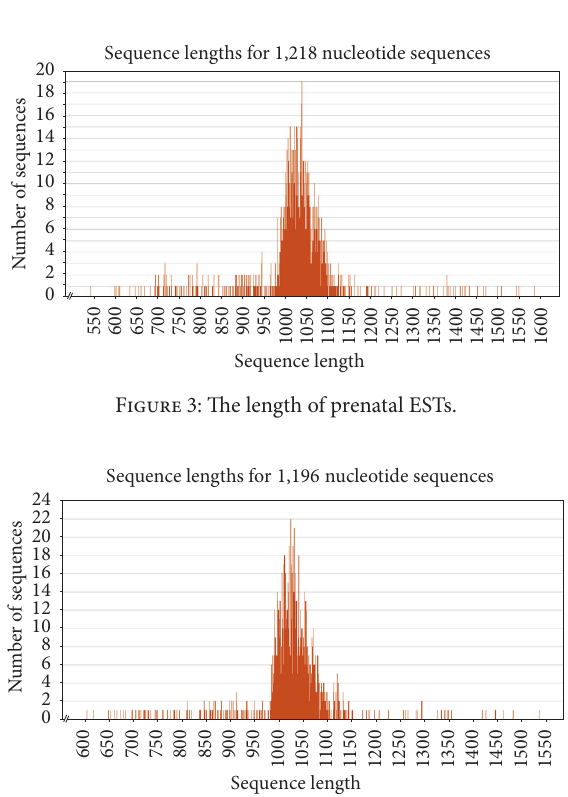
Figure 4: The length of postnatal ESTs.